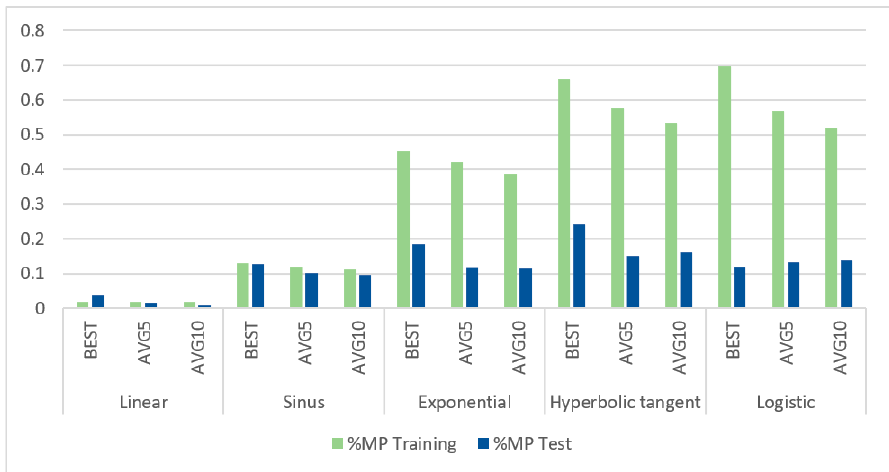
Figure 5. Value of the %MP indicator obtained in the SANN taking into account the activation function used in the hidden layer.